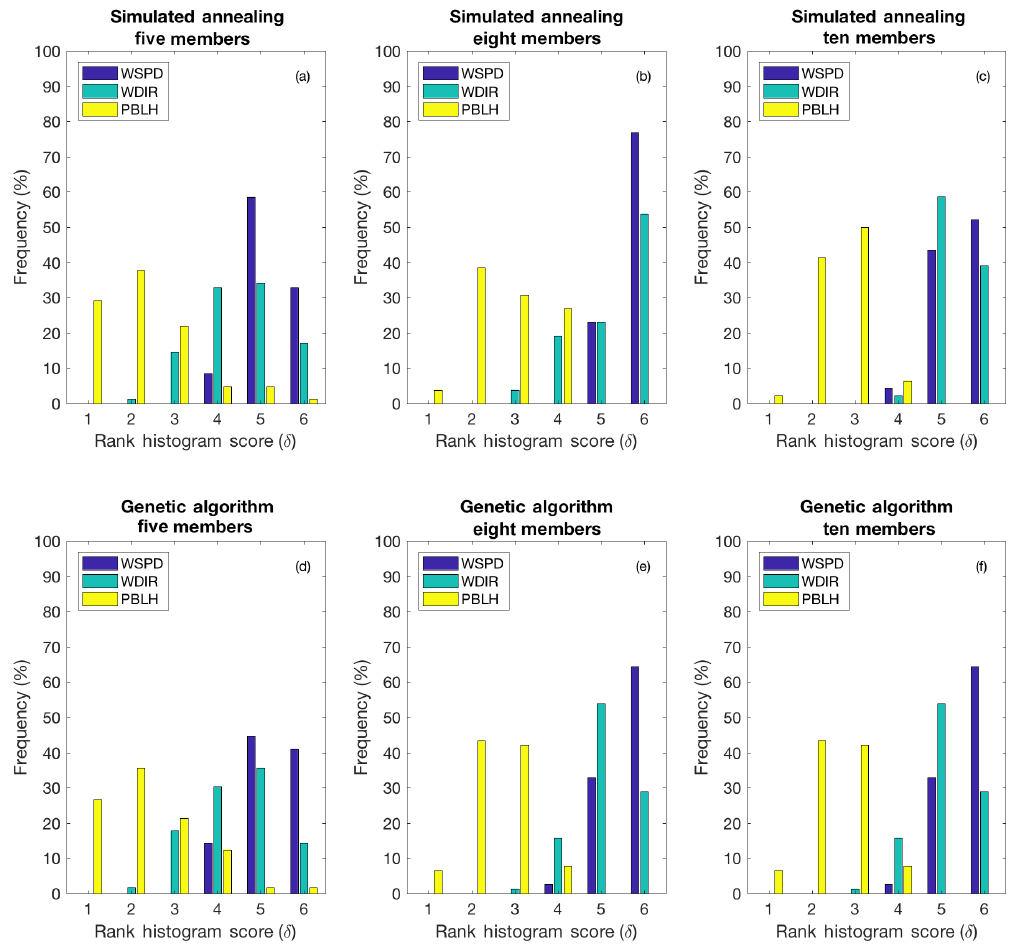
Figure A4. Rank-histogram score of calibrated sub-ensembles of different size generated by simulated annealing (a–c) and the genetic algorithm (d–f) . Each bar represents the frequency of that score for the three different variables: wind speed (WSPD), wind direction (WDIR) and PBL height